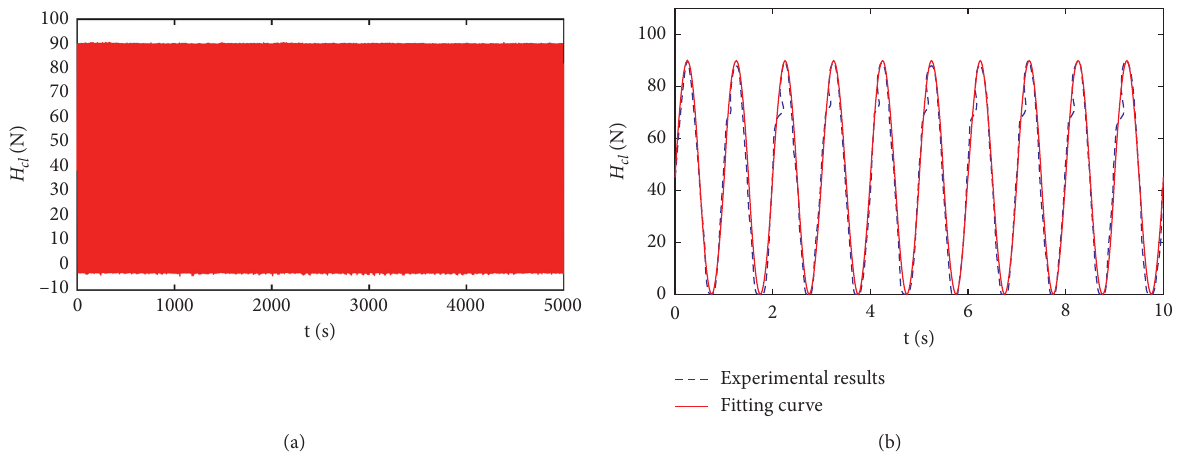
Figure 5: Variation curve of horizontal cyclic loading: (a) output loading of device; (b) fitting